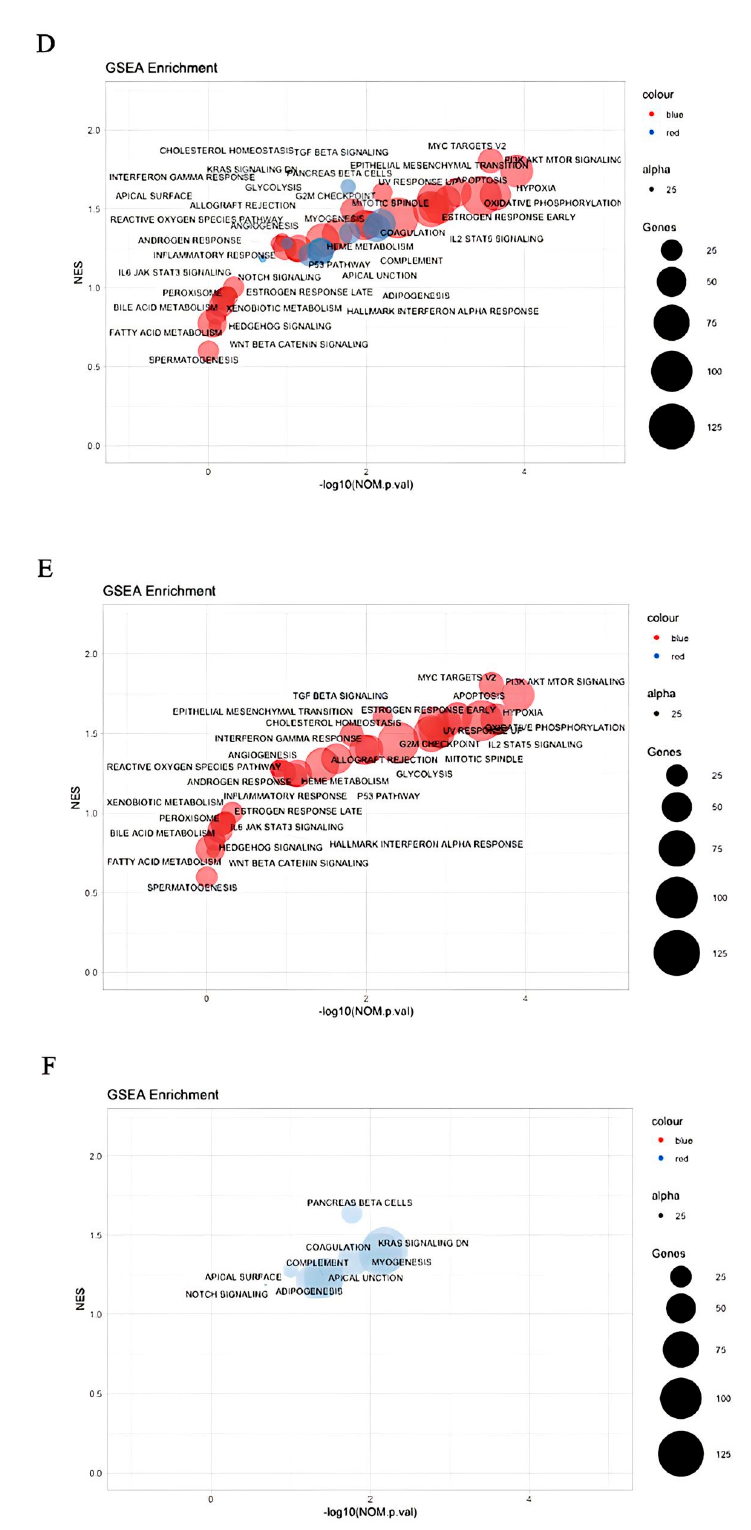
Figure 1. Genomic landscape of keloid. ( A ) Volcano plot of differential gene expression (DEG) of keloid versus control; ( B ) heatmap clustering of gene expression between control, susceptible, and keloid; ( C ) gene ontology hallmark enrichment of DEG; ( D ) overall bubble plot of gene ontology hallmarks; ( E ) increased hallmark enrichment in keloid; ( F ) increased hallmark enrichment in control, decreased enrichment in